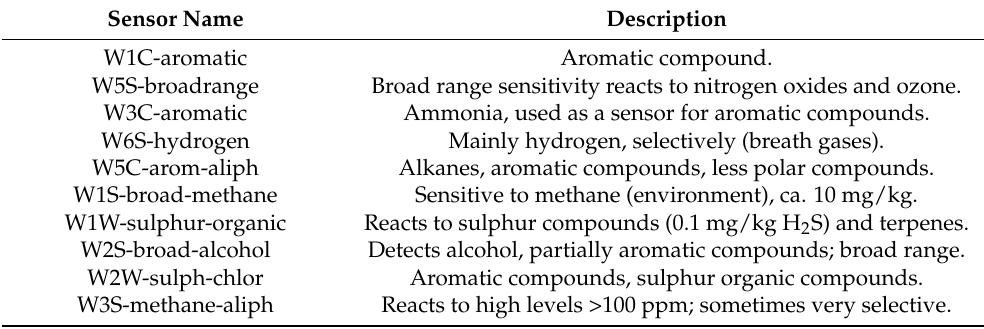
Table 2. Description of sensors in the PEN2 electronic nose (WMA Airsense, Schwerin,